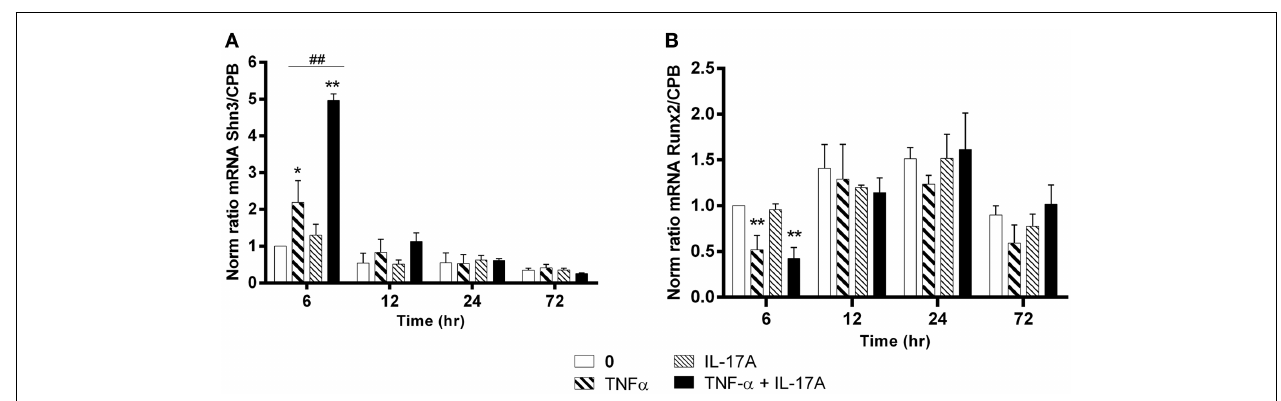
FIGURE 4 | Effects of Il-17A andTNF- α on Schnurri-3 and Runx2 are shown . hMSCs were cultured in osteogenic medium in the presence or absence of TNF- α 1ng/ml and/or IL-17A 50ng/ml. Osteogenic gene expression Shn3 (A) and Runx2 (B) were measured by qRT-PCR at early time points of 6, 12, 24, and 72h. Results were analyzed using theWilcoxon test. * p < 0.05; ** p < 0.005 vs. induction medium alone (0), # p < 0.05TNF- α alone vs. IL-17A + TNF- α